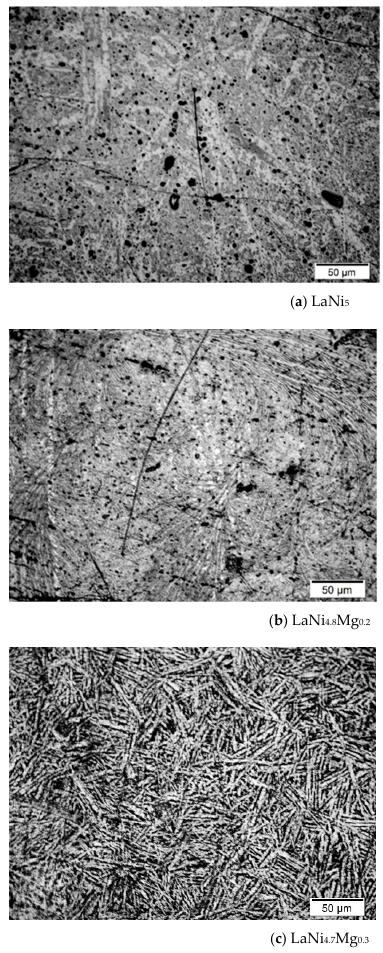
Figure 7. Surface morphology of LaNi 5-x Mg x alloys after 120 h of exposure in 6M KOH at open circuit potential.